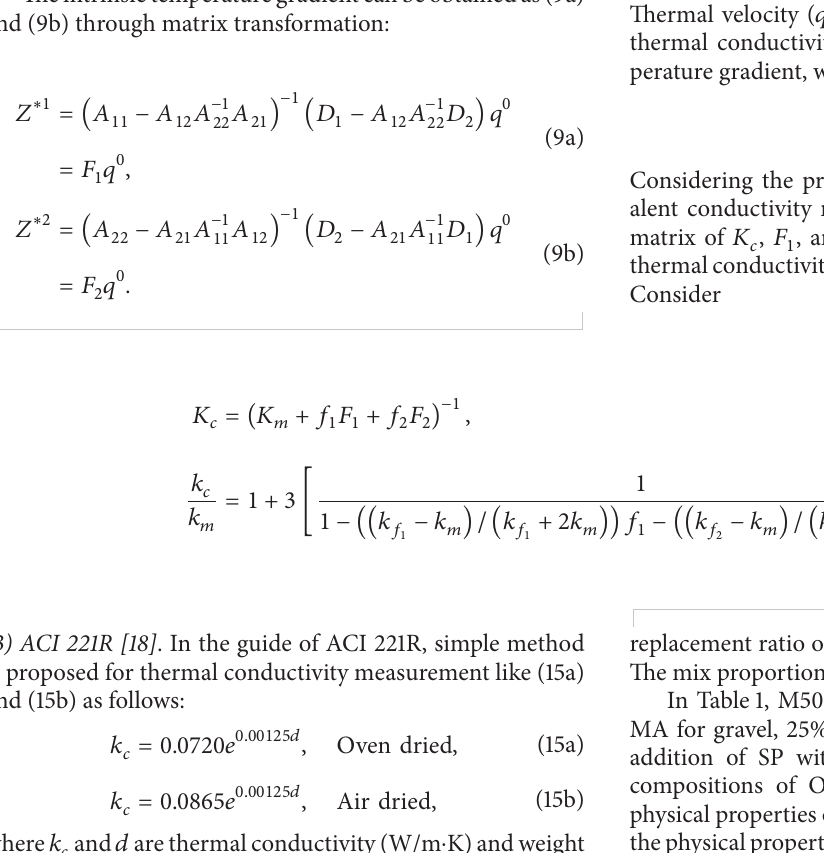
where 𝑍 𝑖 and 𝑍 𝑖∗ are disturbed temperature gradient and intrinsic temperature gradient from Eshelby model in 𝑖 component. 𝑍 is average of disturbed temperature